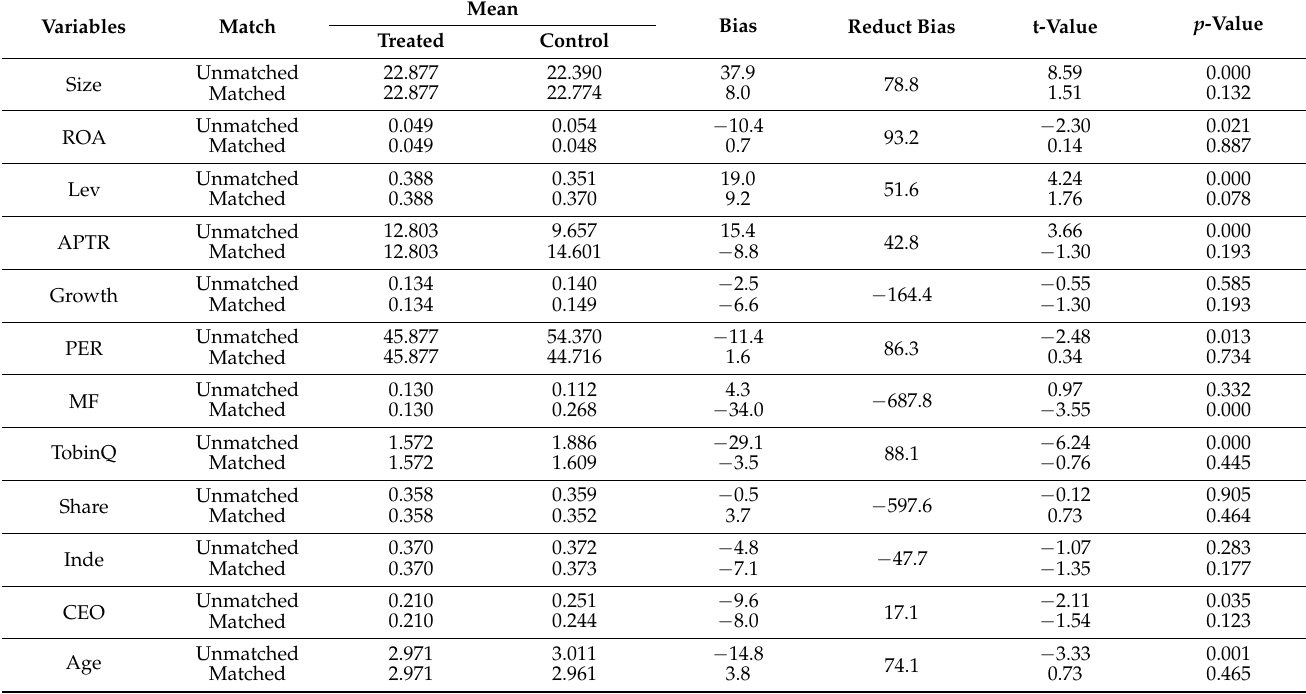
Table A4. Balance hypothesis test: 1:1.